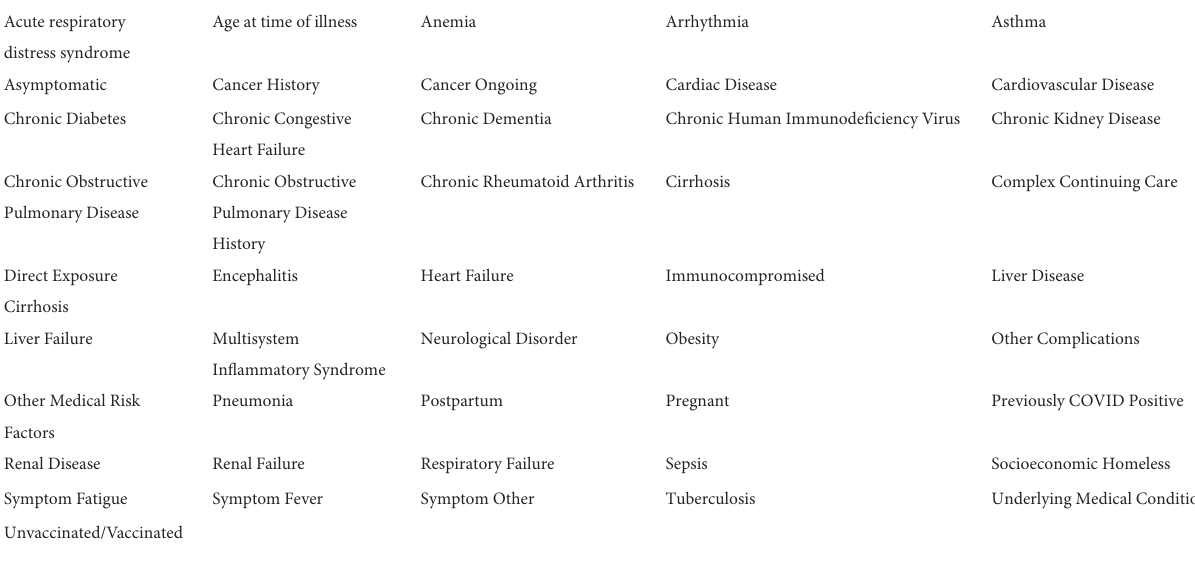
TABLE 2 The filtered list of patient features, with modified vaccination statuses and high collinearities